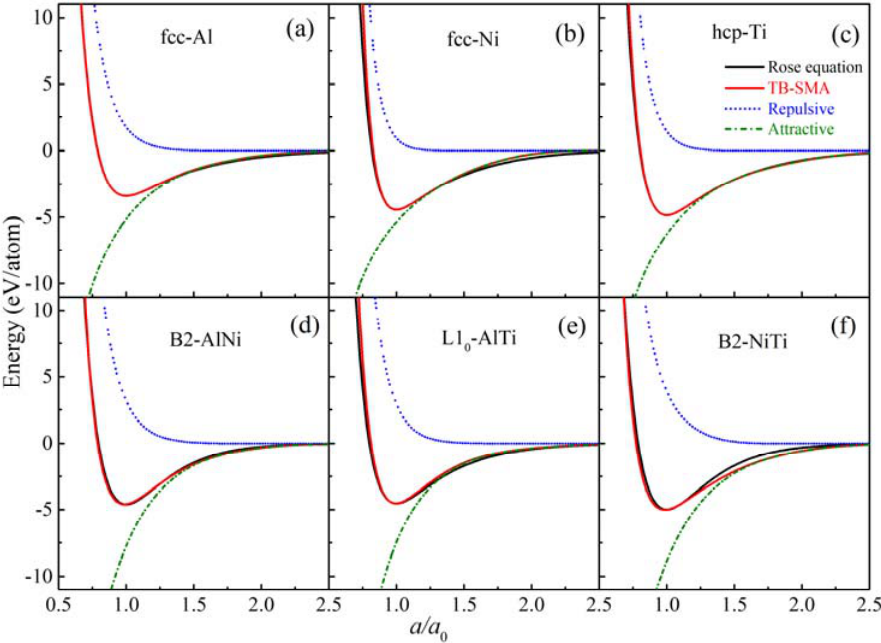
Figure 1. The equations of state (EOS) deduced from TB-SMA potential and the corresponding Rose equations for ( a ) fcc − Al, ( b ) fcc − Ni, ( c ) hcp − Ti, ( d ) B2 − AlNi, ( e ) L10 − AlTi and ( f ) B2 − NiTi.